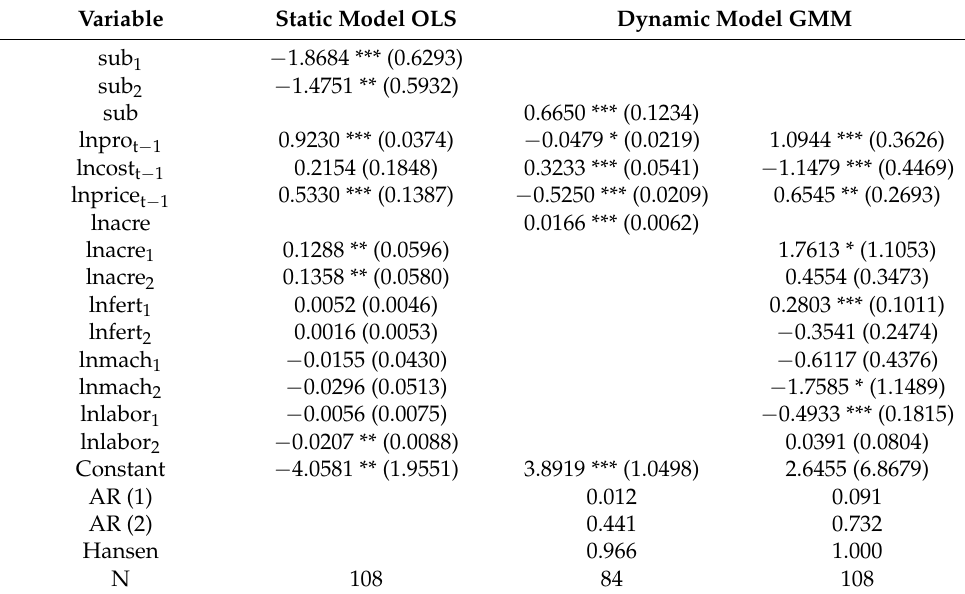
Table 2. Empirical results with respect to the production effect of cotton subsidies in 12 provinces in China from 2011 to 2020.